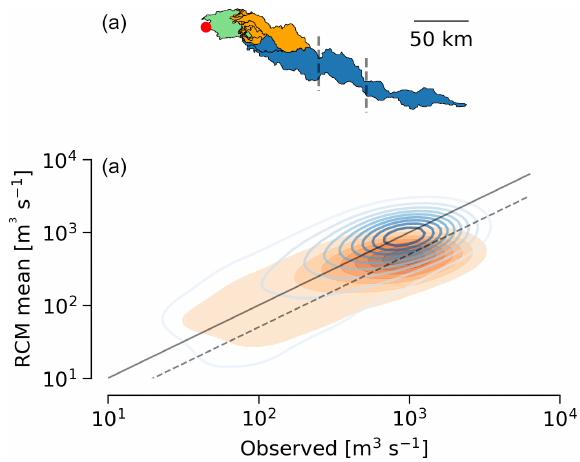
Figure 8. Watson River and manually adjusted basin area. (a) Map view showing land and ice basin from this work – green and orange, respectively, are the same as the region shown in Fig. 7, and two ad- ditional basins to the south are shown in blue. Vertical dashed lines denote approximate location of 1500 and 1850m elevation. (b) Ker- nel density estimate (concentration of points) comparing observed vs. average of RACMO and MAR RCM runoff for the default land and ice basin (orange; filled) and with the additional southern basins (blue; lines). Solid and dashed lines are 1 : 1 and 2 : 1 (respectively) observed-to-RCM